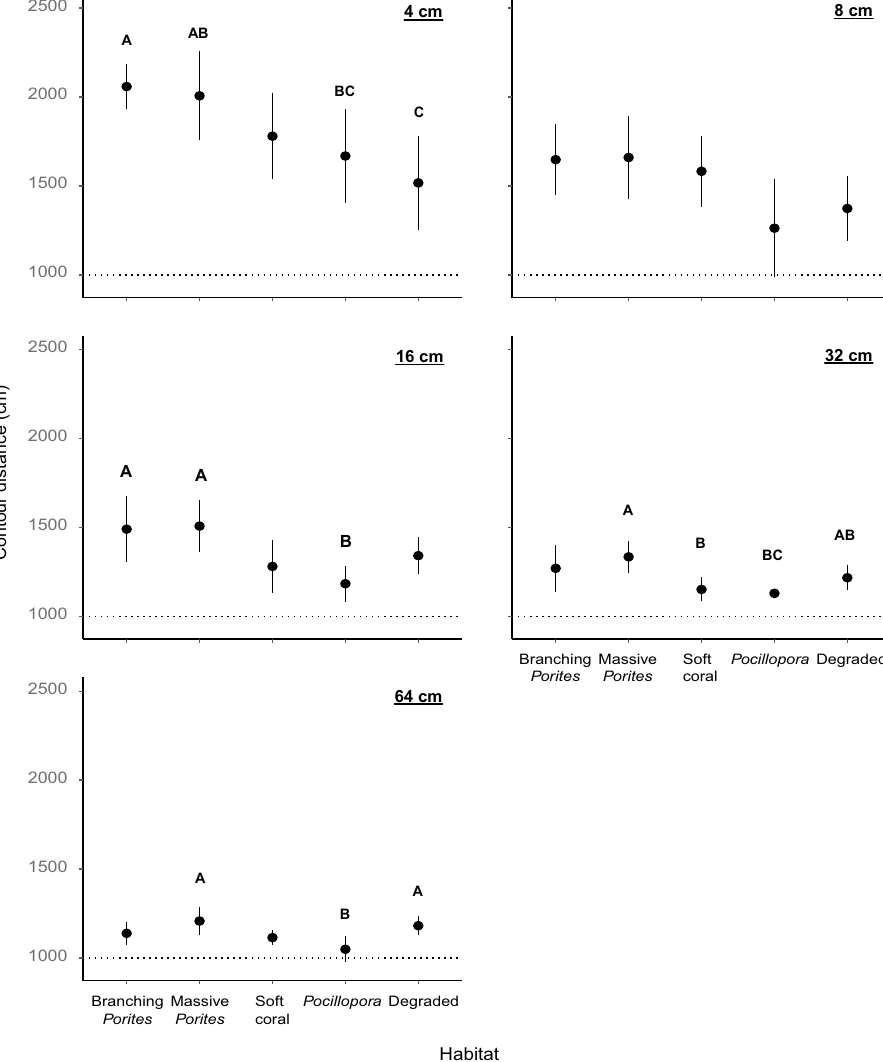
Figure 3. Modelled contour distance ( ± 95% confidence intervals) measured along 10 m transects at scales 4–64 cm with measuring wheels (wheel diameters, cm: 3.99; 7.97; 15.95; 31.89; 63.79), in different coral reef habitats ( n = 4–12 per habitat). Significant differences between habitats revealed by post hoc Tukey pair-wise comparisons are illustrated by the pairing of letters (P <